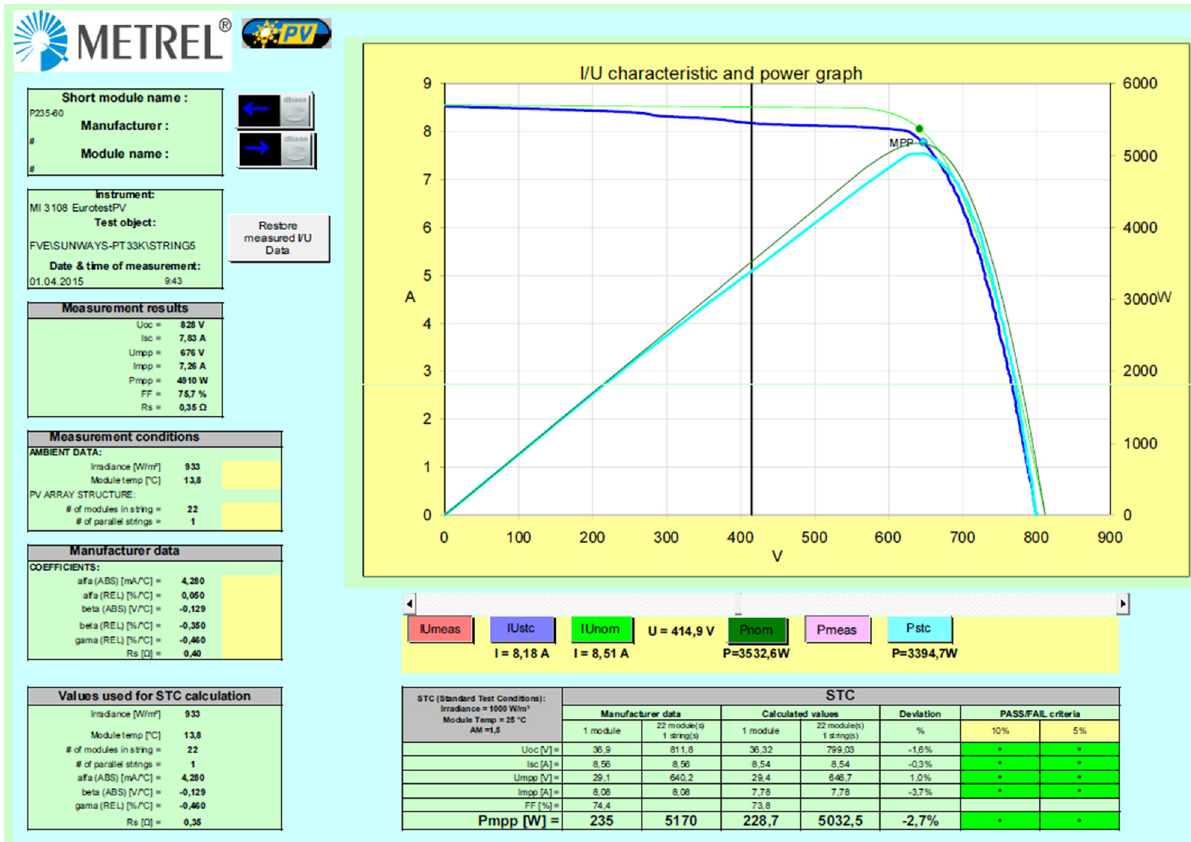
Figure 14. I-V curve measurement of the entire string with no problem detected